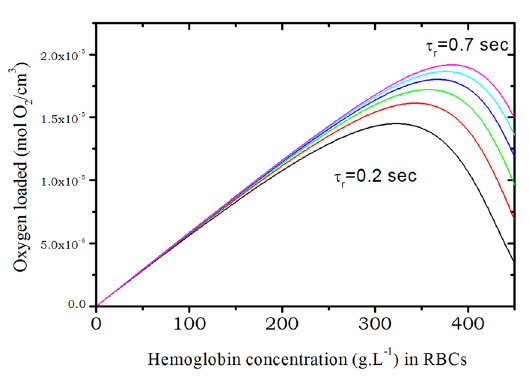
Figure 6. Number of moles of oxygen loaded by hemoglobin per cm 3 in the red blood cells as a function of the hemoglobin concentration in g . cm − 3 for different transit times. We assume that at time t = 0 there was no O 2 bounded and that the oxygenation is performed within a transit time varying from 0.2 to 0.7 sec without Hb diffusion.